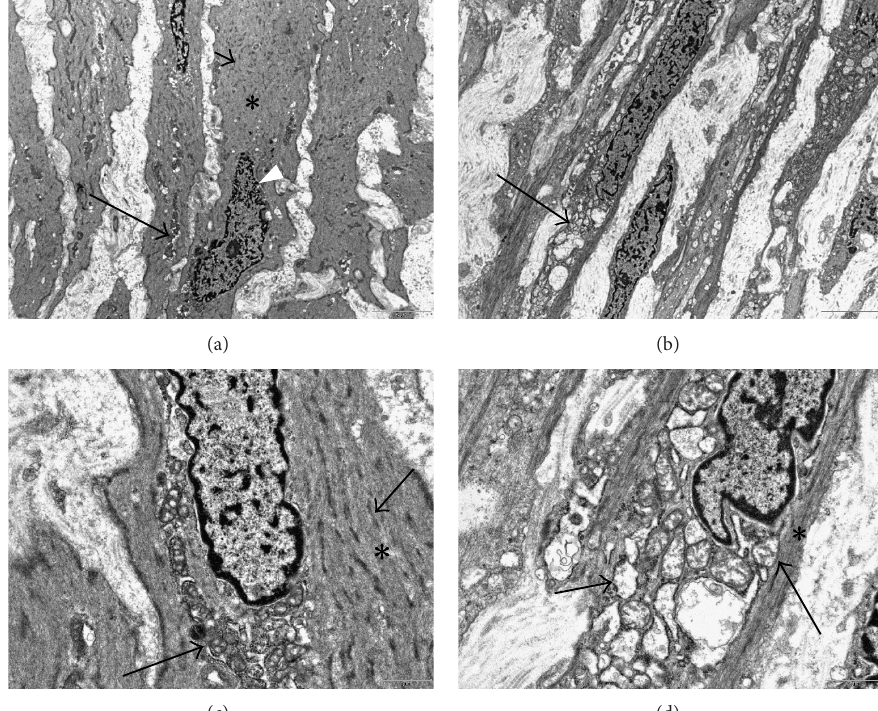
Figure 6: Ultrastructural features of phenotypic transformation. This side-by-side comparison of myometrial smooth muscle cells in (a) with the transformed fibroid myocytes in (b) illustrates some of the electron microscopic features of the phenotypic transformation. The myometrial myocytes in (a) display abundant, relatively homogeneous cytoplasm that is filled with fine actin filaments (asterisk), oriented in parallel array in the long axis of the cells. Also evident are interspersed dense bodies (short arrow), focal clusters of mitochondria (long arrow), and a nucleus with a crenulated nuclear border (arrowhead) that is suggestive of the contractile state. In contrast, the fibroid in (b) exhibits more intercellular stroma and slender, streamlined cells with less cytoplasm, marked reduction in the fine actin filaments, increased swollen endoplasmic reticulum (arrow), and elongated, pointed nuclei. In (c), the myometrial myocyte displays a cytoplasm filled with actin fine filaments (asterisk), interspersed dense bodies (short arrow), clusters of mitochondria (long arrow), and a nucleus with a rounded end. In contrast, the fibroid myocyte in (d) exhibits extensive, dilated endoplasmic reticulum (short arrow), swollen mitochondria (long arrow), greatly reduced myofilaments limited to the periphery of the cell (asterisk), and a nucleus with a pointed end. Original magnification of both